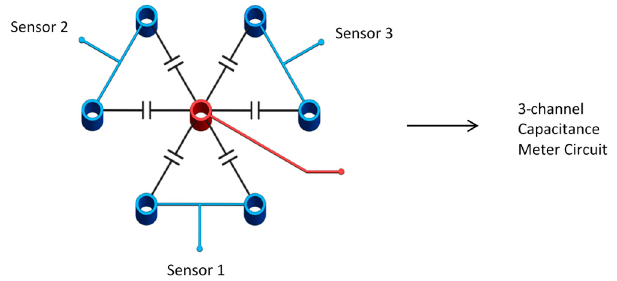
Figure 3. Three-sensor configuration.